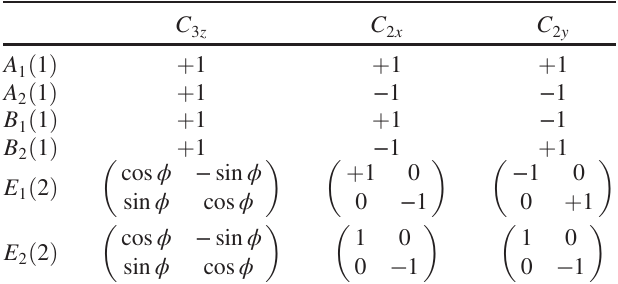
TABLE I. Nontrivial irreducible representations of the space group D 6 . Each representation has the degeneracy shown in parentheses. We also list the action of the symmetry operations for each representation, where ϕ ¼ 2 π = 3